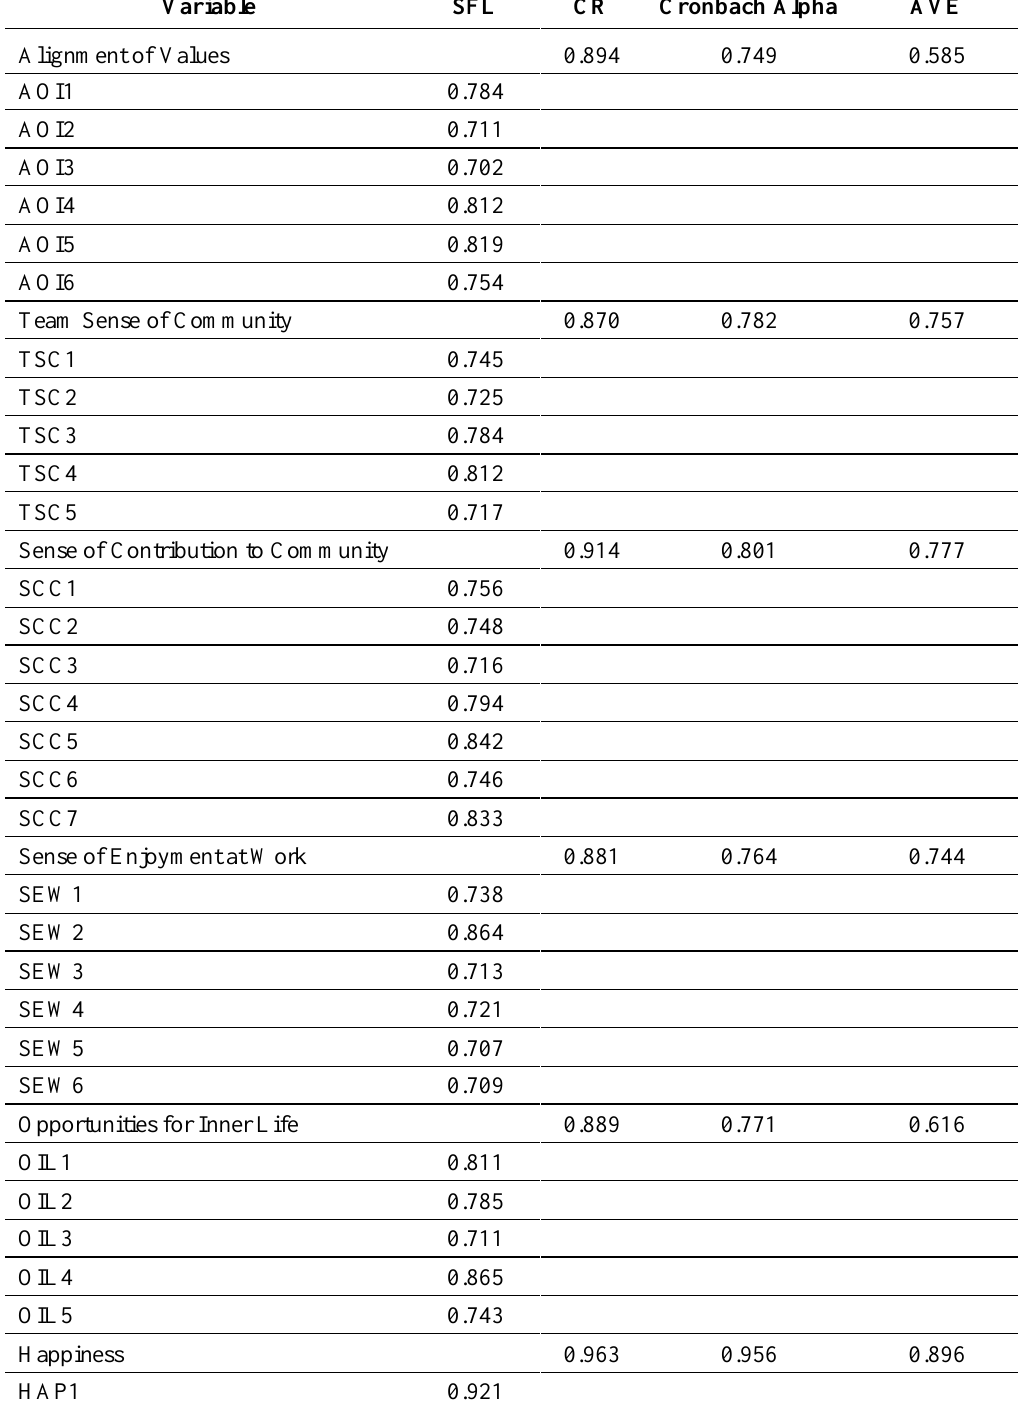
Table.1. Factor Loadings and